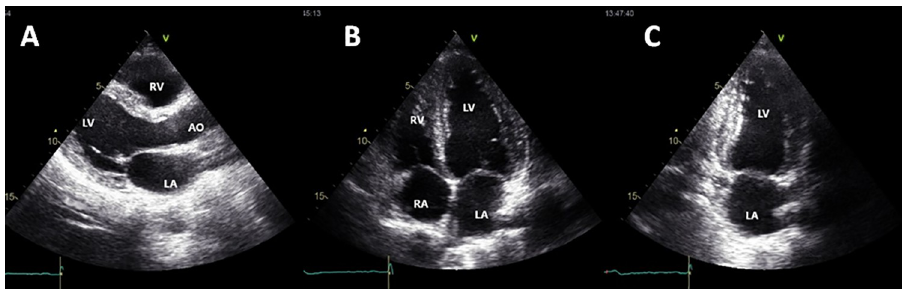
Fig 1. Echocardiographic views selected for the focused echocardiogram. A: Parasternal long-axis view; B: Apical four-chamber view; C: Apical two-chamber view. LA: left atrium; RA: right atrium; LV: left ventricle; RV: right